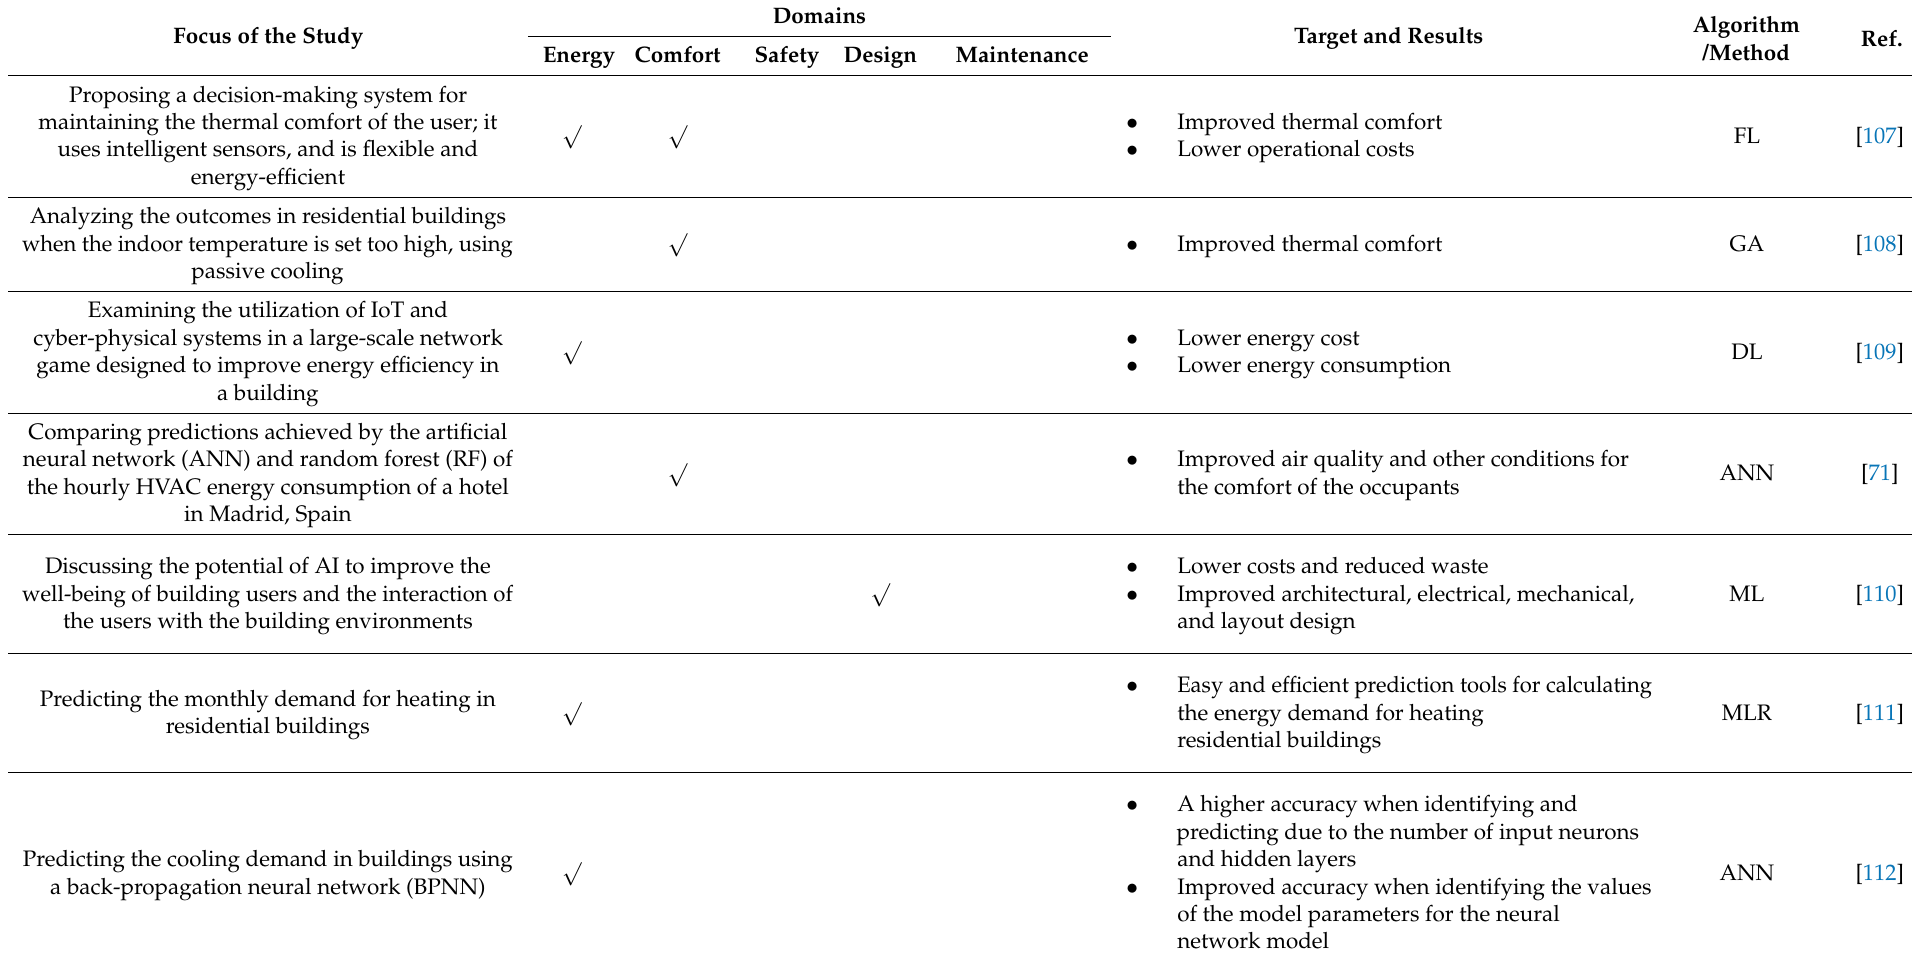
Table 3. Applications of the AI-based approaches used in building energy